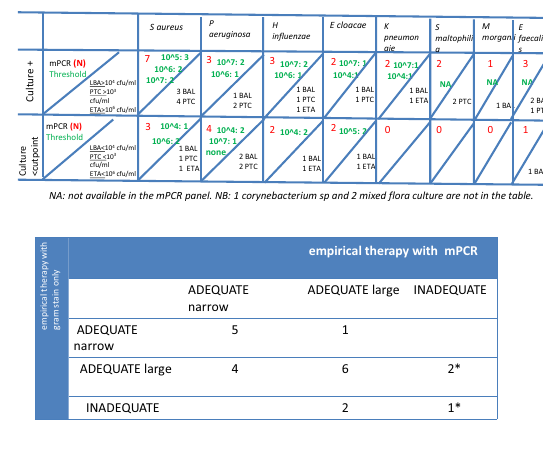
Table 1 Demographic characteristics of the population and main results